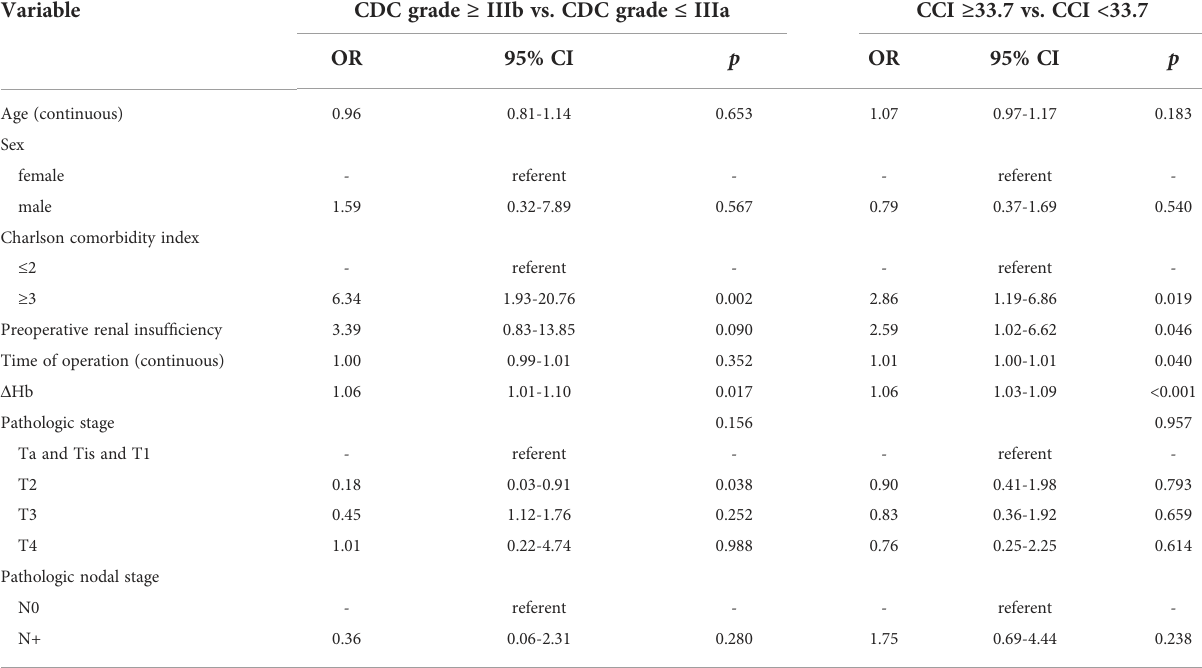
TABLE 4 Logistic regression analysis of variables associated with major complication for all